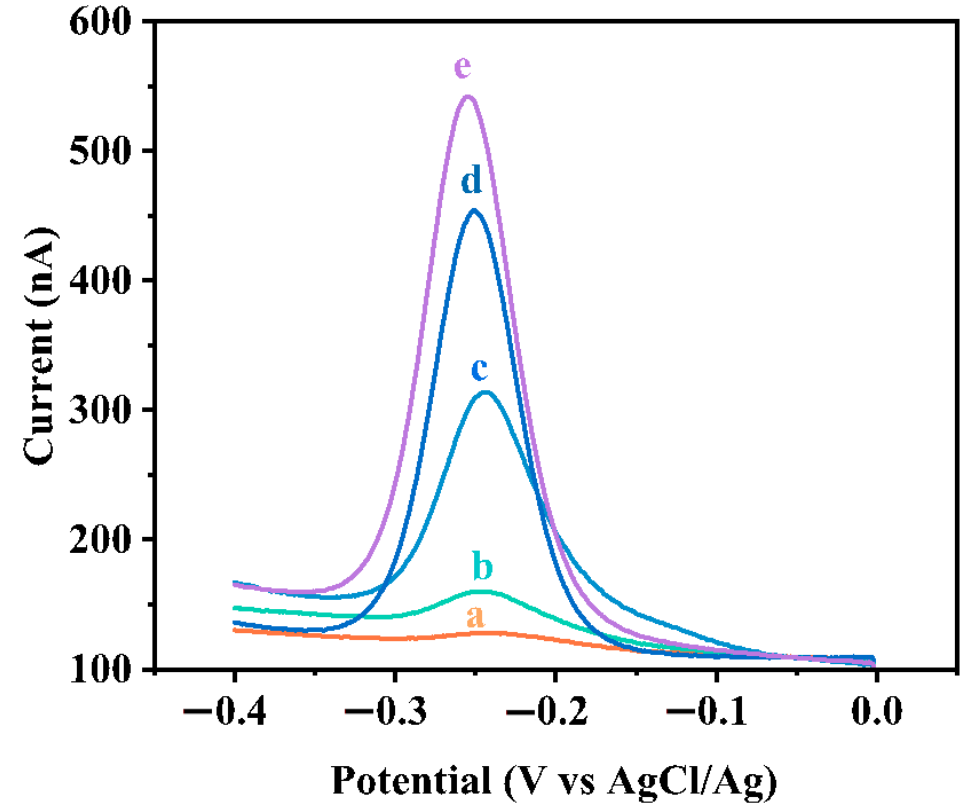
Figure 9. Typical SWV responses of the electrochemical DNA sensors to different concentrations of FR, from bottom to top ( a to e ): 0 nM, 1 nM, 50 nM, 500 nM, 1 μ M in a buffer solution (10 mM Tris–HCl, 100 mM NaCl, 20 mM MgCl 2 , pH 7.4). Tris–HCl, 100 mM NaCl, 20 mM MgCl 2 , pH